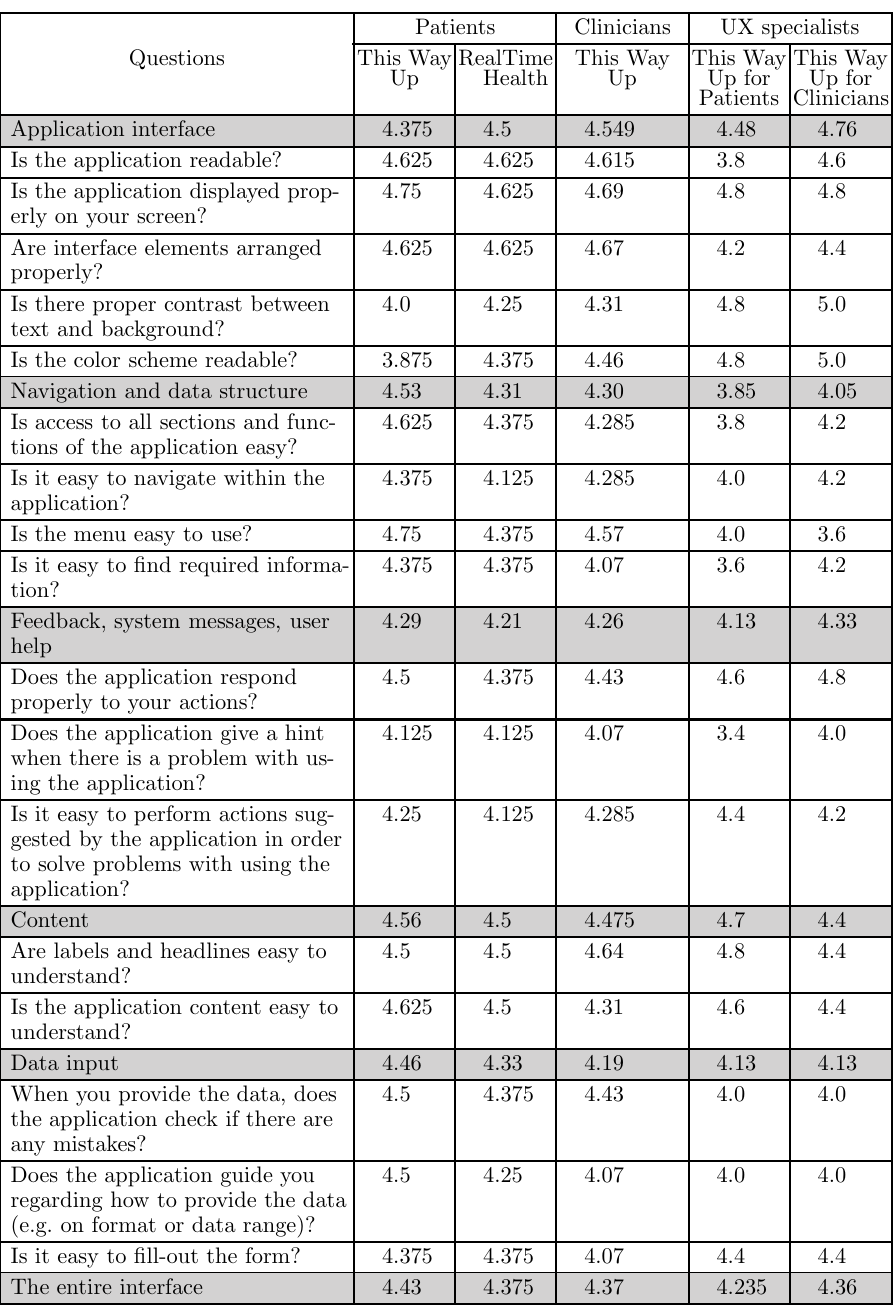
Table 3. Results of expert